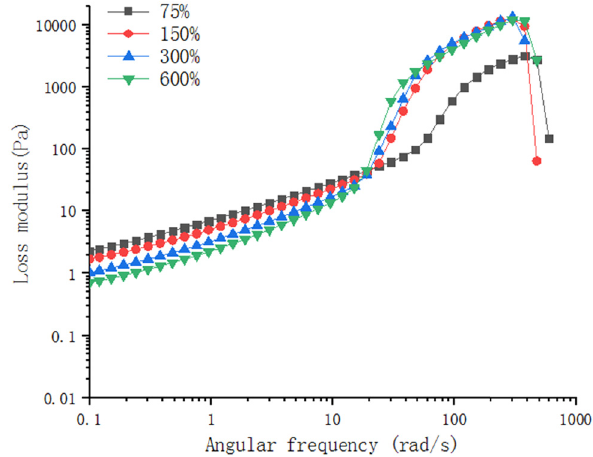
Figure 7: The relationship between the energy dissipation modulus and the frequency of the 0.15% MWCNTs – PVP/SiO 2 – STF system.